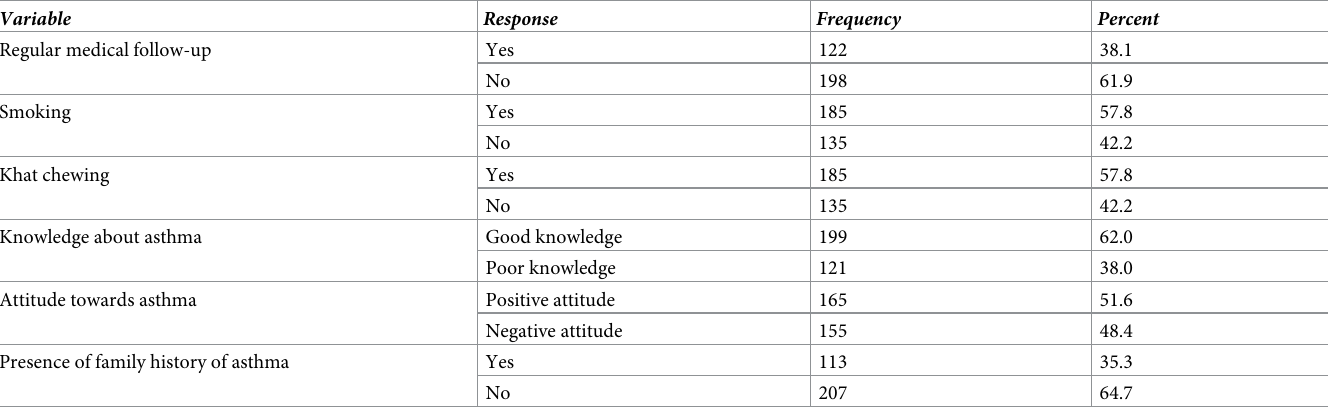
Table 2. Patient related characteristics of study